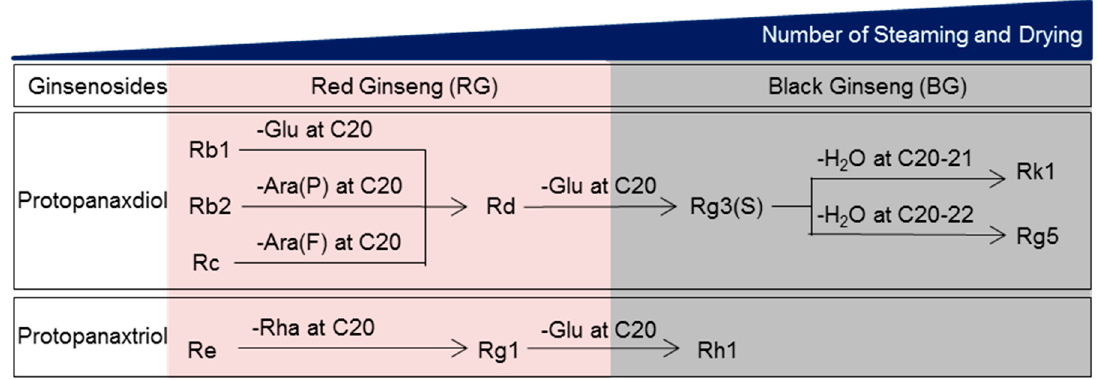
Figure 1. Transformation of the ginsenoside profile of ginseng with increased numbers of steaming and drying cycles. There are two types of ginsenosides: protopanaxadiol-type saponins (e.g., Rb1, Rb2, Rc, Rd, Rg3, Rg5, and Rk1) with sugar moieties attached to hydroxyl groups at C3 and C20 and protopanaxatriol type saponins (e.g., Re, Rg1, and Rh1) with sugar moieties attached to hydroxyl groups at C3, C6, and C20. The outer residues from position C20 of Rb1, Rb2 and Rc are glucose, arabinose (pyranose form), and arabinose (furanose form), respectively. These outer residues are removed to achieve Rd. The remaining glucose of Rd at C20 can be deleted to form Rg3. Sequentially, Rk1 with the double bond at C20-21 and Rg5 with a double bond at C20-22 are derived from Rg3 by dehydration at C20. Re, a protopanaxatriol type, can also be transformed to Rg1 after deletion of the rhamnose residue at C6. The outer glucose residue of Rg1 at C20 is removed to form Rh1. Glu: glucose; Ara(P): arabinose (pyranose form); Ara(F): arabinose (furanose form); Rha: rhamnose.